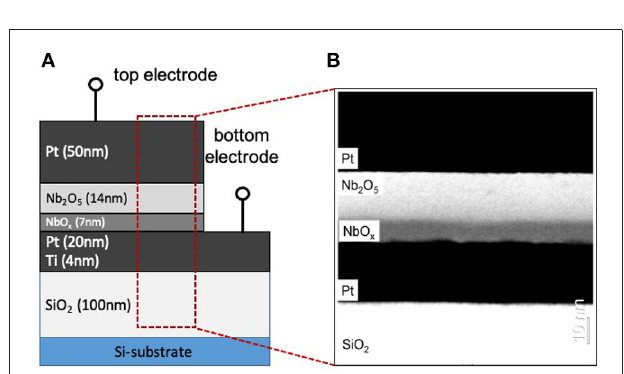
certain point, however, the loop lobe area begins to decrease progressively, as expected of all resistance switching memories (Chua, 2014), until, for the largest frequency value, the locus reduces to a straight line, as is the case for all generic memristors (Chua,